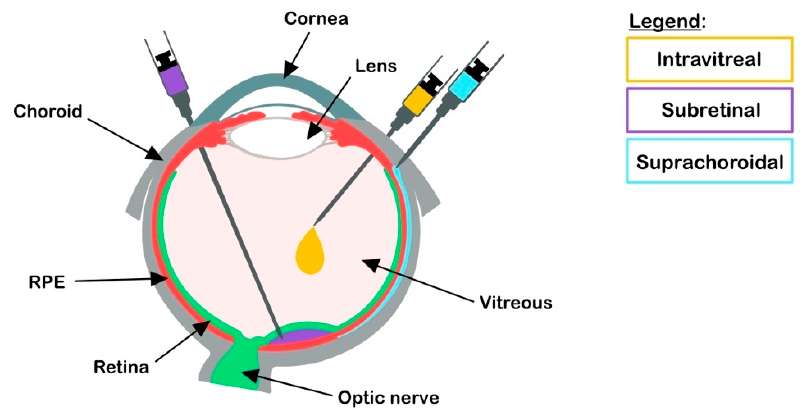
Figure 1. Drug delivery routes. Ocular delivery routes at the indicated locations are depicted. RPE: retinal pigment epithelium.